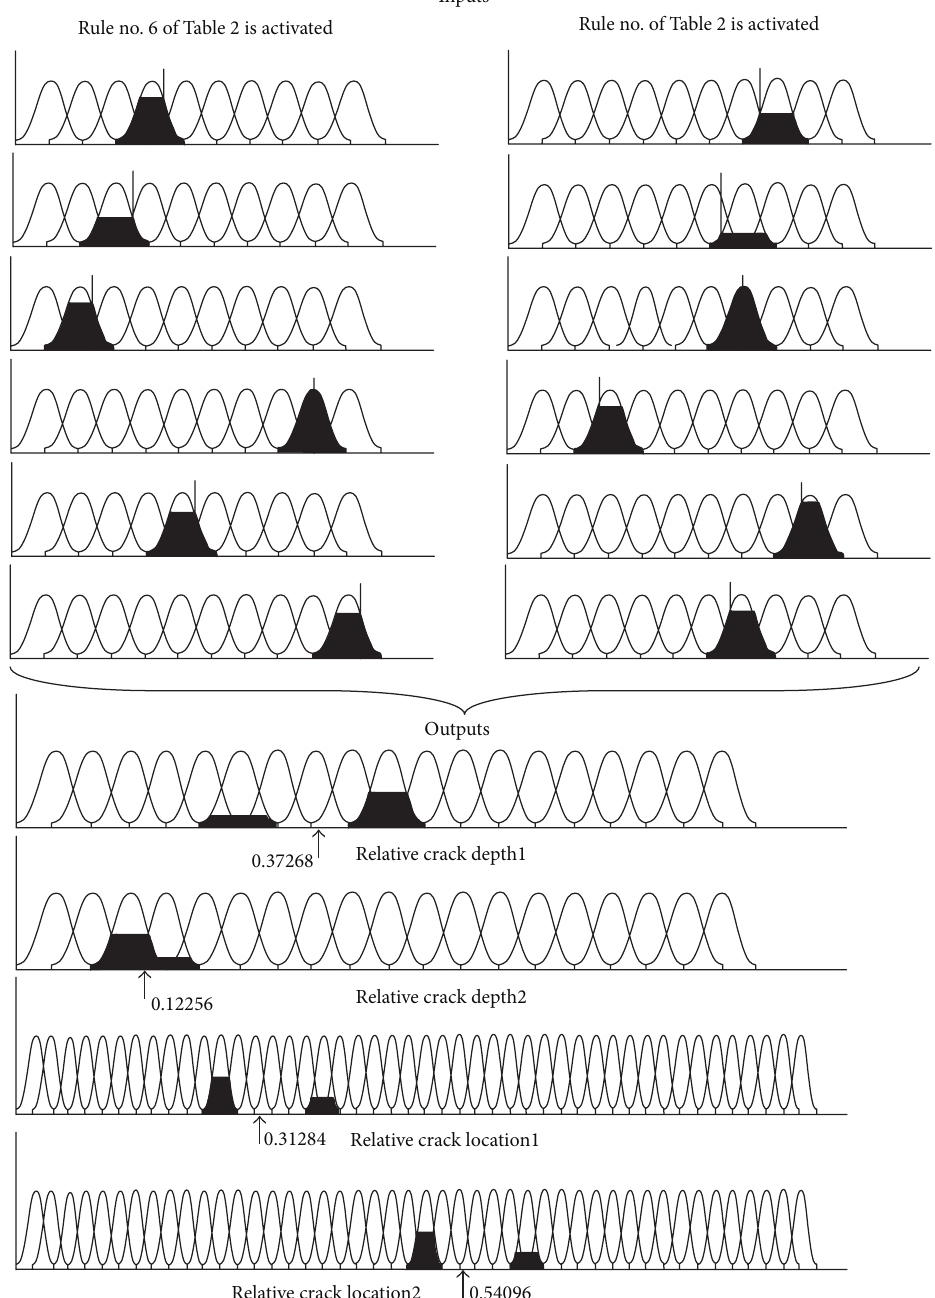
Figure 8: Resultant values of relative crack depth and relative crack location when rules 6 and 19 of Table 2 are